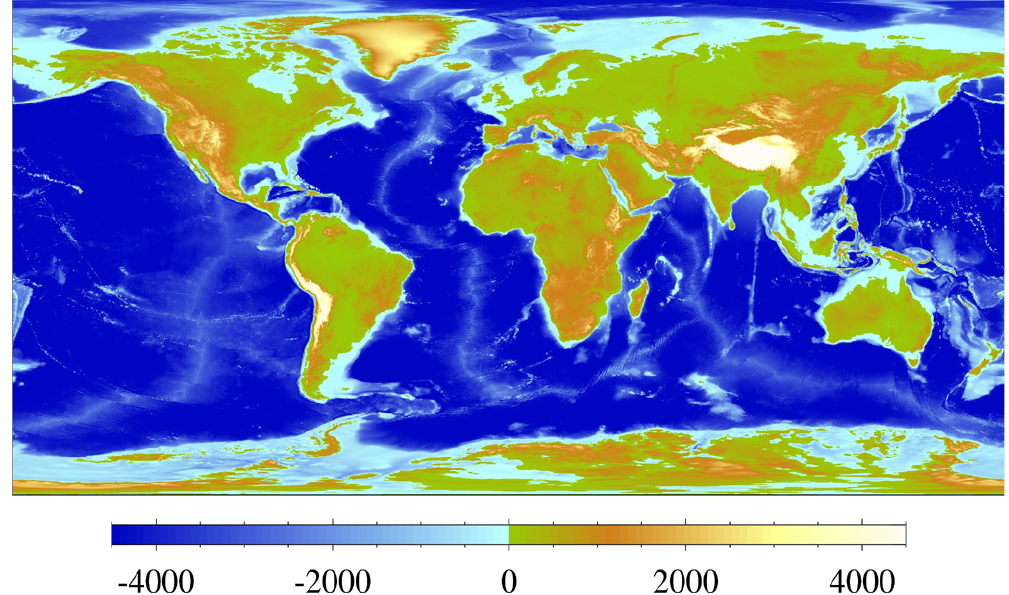
Figure 1. RTopo-1 global bedrock topography. On continents outside Antarctica, this represents the topography of the solid surface (including bottom of lakes, surface elevation of glaciers and continental ice caps) and mirrors the S-2004 data